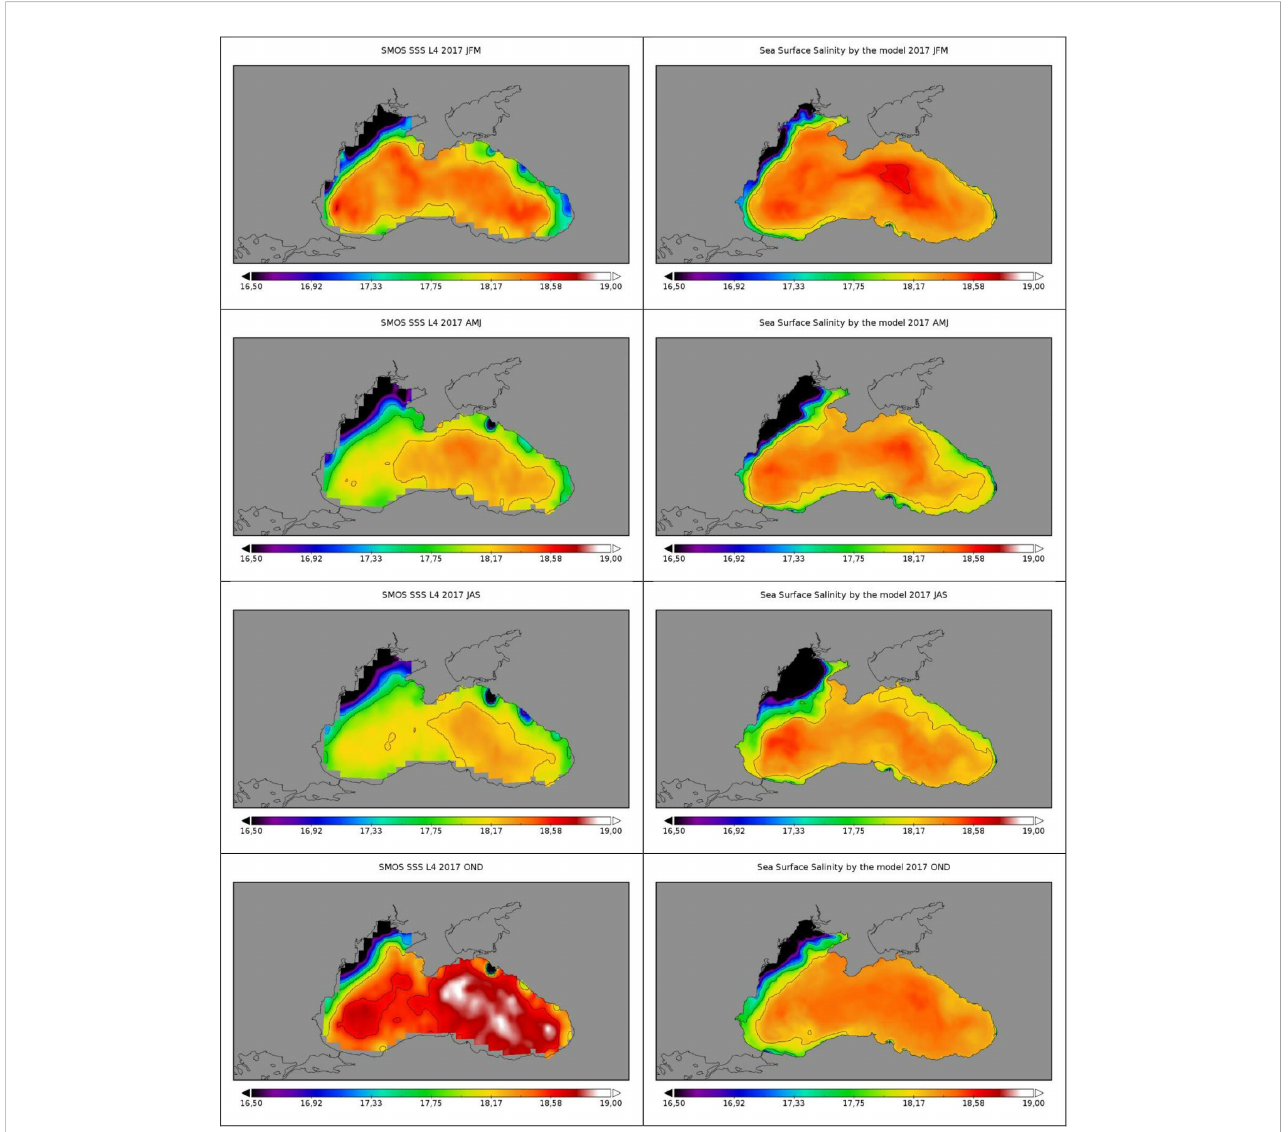
FIGURE 7 Seasonal evolution of the SSS from SMOS (left) and modelling (right) over 2017. First row: winter (January-February-March), second row: spring (April- May-June), third row: summer (July, August, September), Last row: fall (October, November,